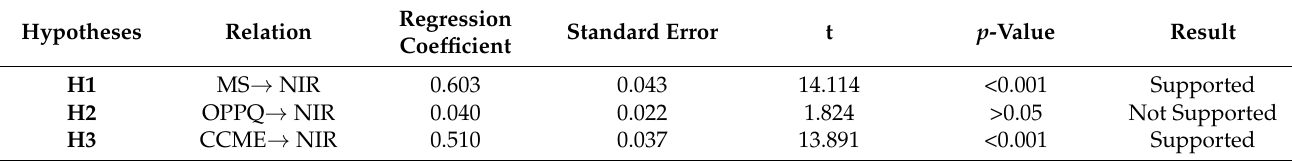
Table 3. Research hypotheses and statistical